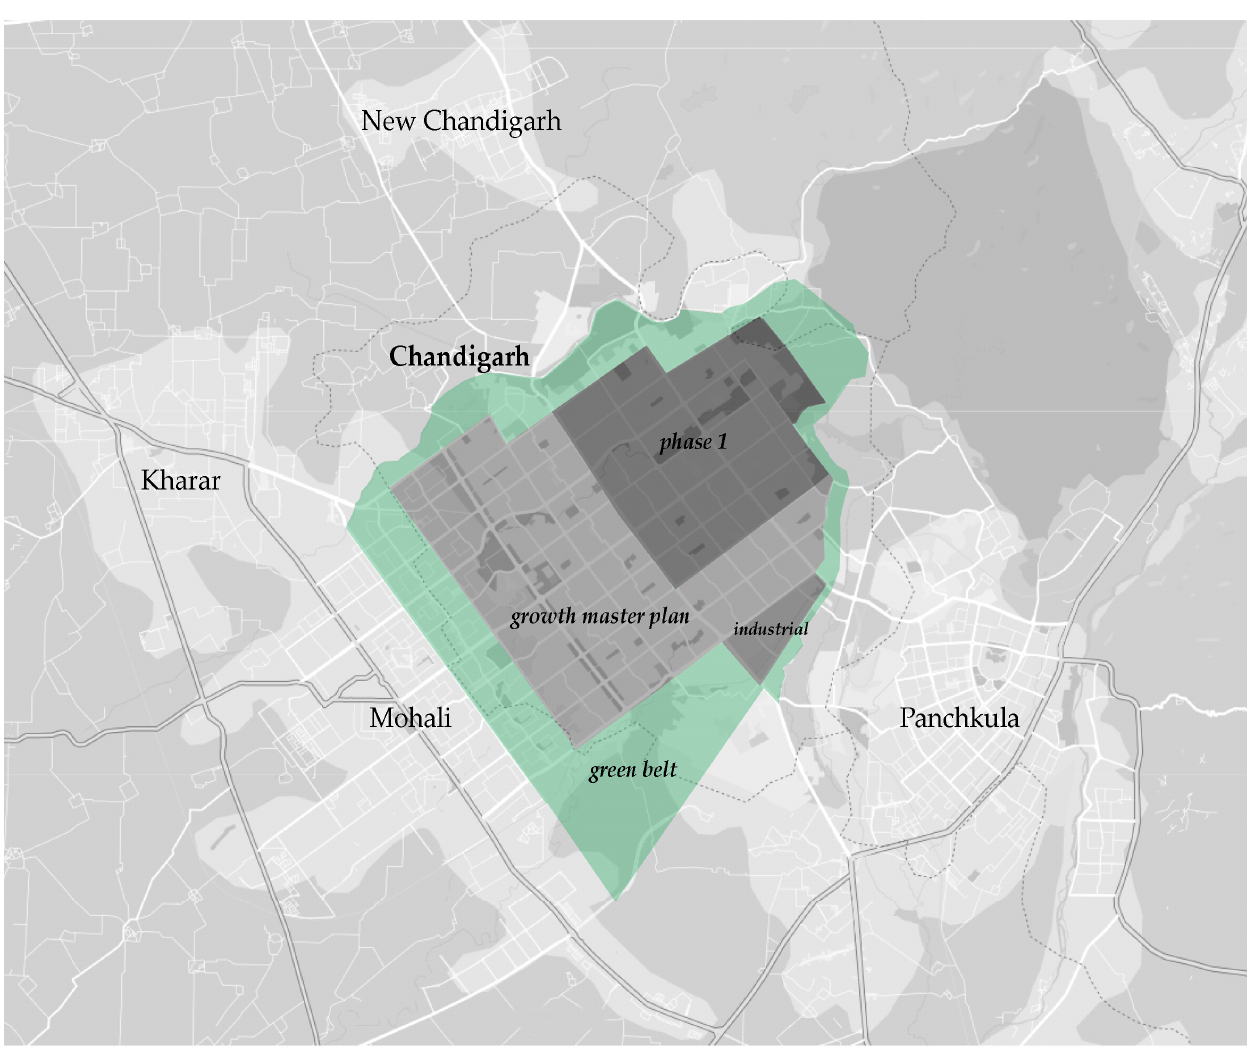
Figure 5. Chandigarh Master Plan on the current city. Source: Authors based on a map from Google Maps.